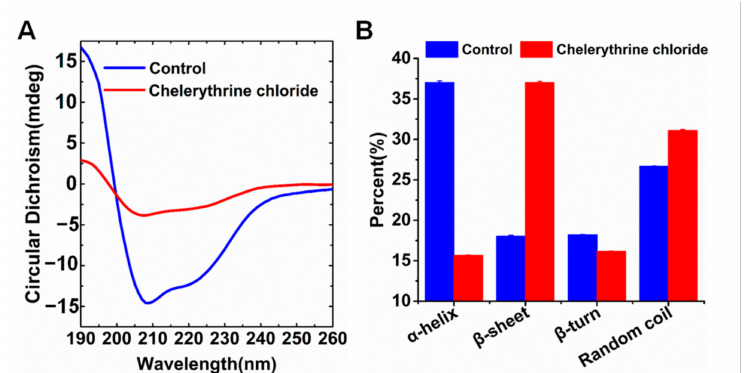
Figure 4. Effect of chelerythrine chloride on second structure of UreG. ( A ) Circular dichroism (CD) spectroscopies of UreG with (red) or without (blue) chelerythrine chloride. ( B ) The composition of the secondary structure in UreG with (red) or without (blue) chelerythrine chloride.